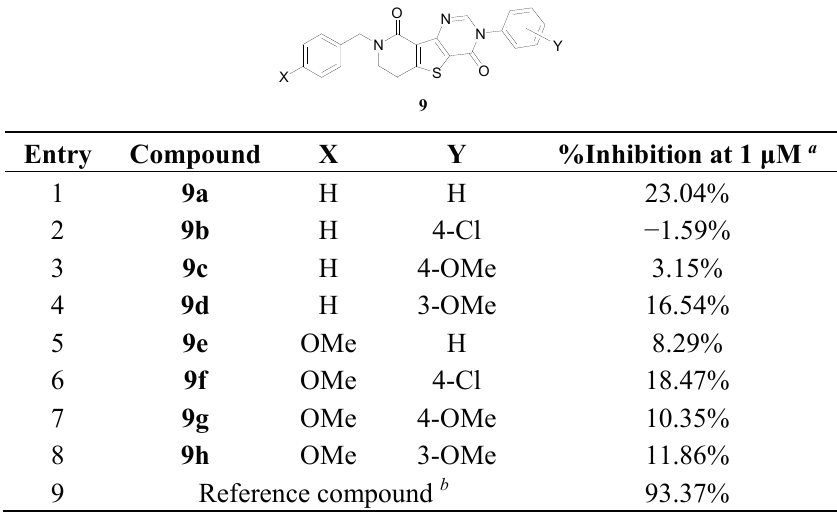
Table 1. Inhibitory activities of the synthesized dihydropyridothienopyrimidin-4,9-diones 9 against